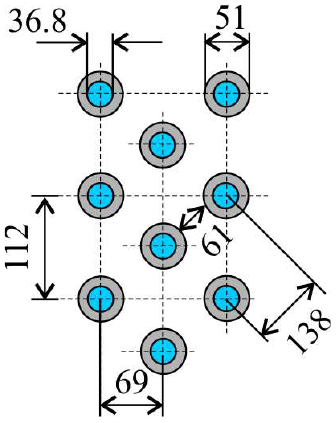
Figure 4. Investigated staggered tube arrangement (all dimensions are in (mm)).